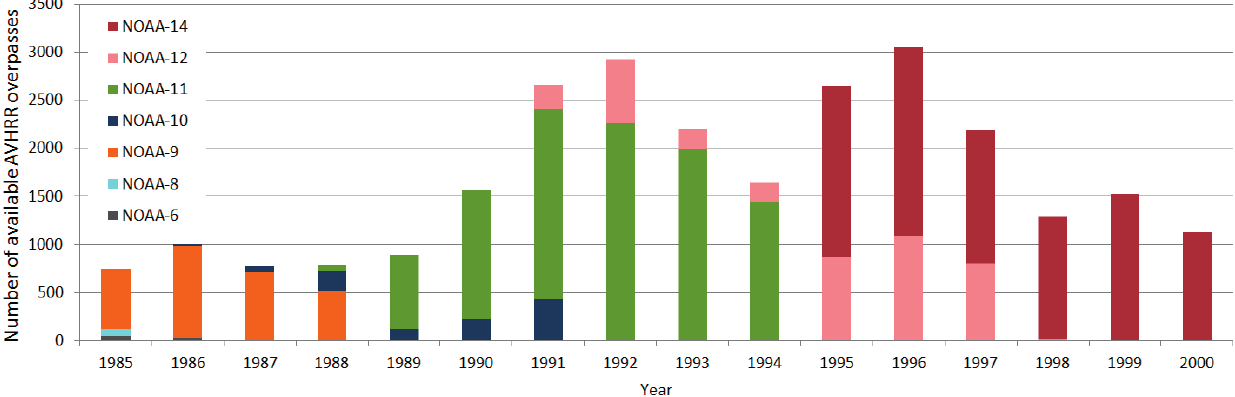
Table 3. Spectral band widths (µm) and operational phases of AVHRR